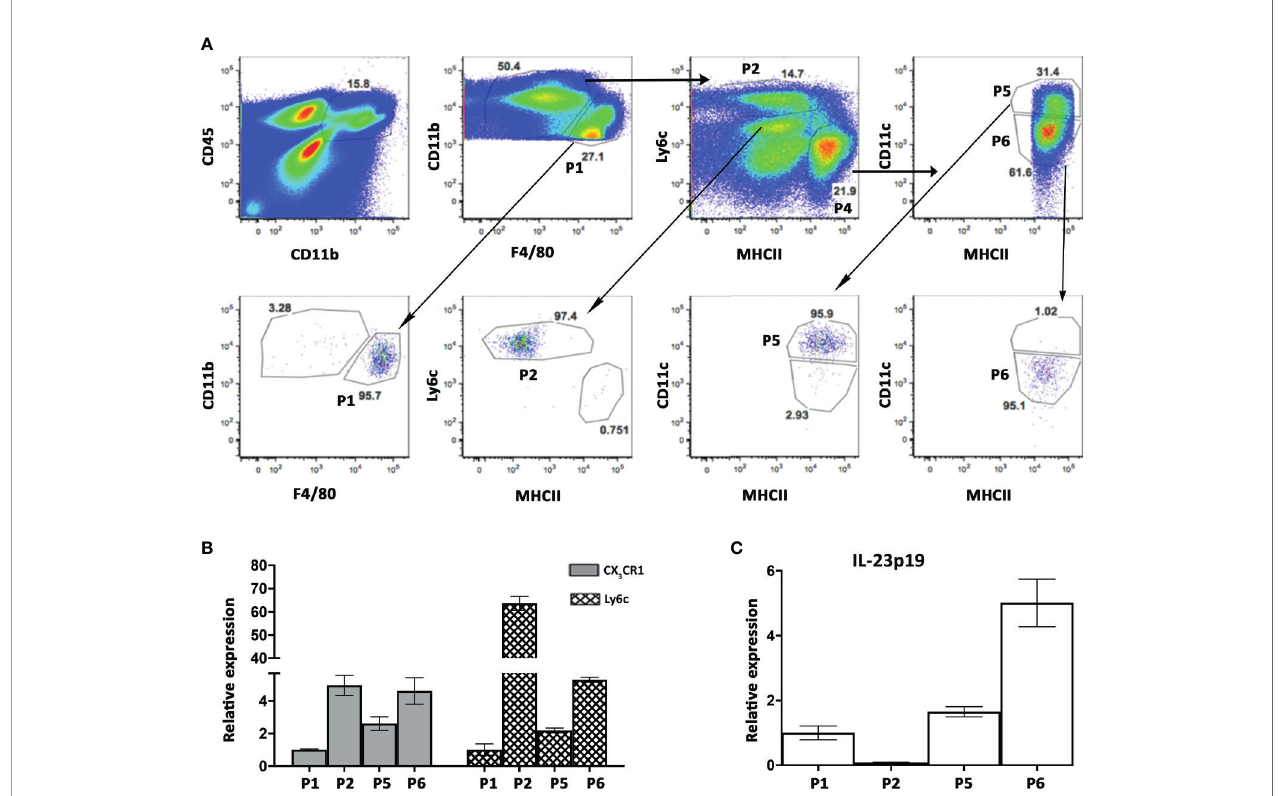
FIGURE 5 | High expression levels of IL-23 mRNA by hepatic MNPs population expressing both CD11c and CX 3 CR1. (A) Flow cytometry sorting strategy of hepatic MNPs sub-populations from autoimmune cholangitis mice, 8 weeks following 2OA-BSA immunization (upper panel, and post-sorted cell populations (lower panel). (B) Graphical summary of qPCR analysis showing fold mRNA expression of CX 3 CR1, Ly6C (B) and IL-23p19 (C) in sorted cell populations. Graph depicts means (SEM) of two independent experiments; each experiment comprised of pooled RNA from 5